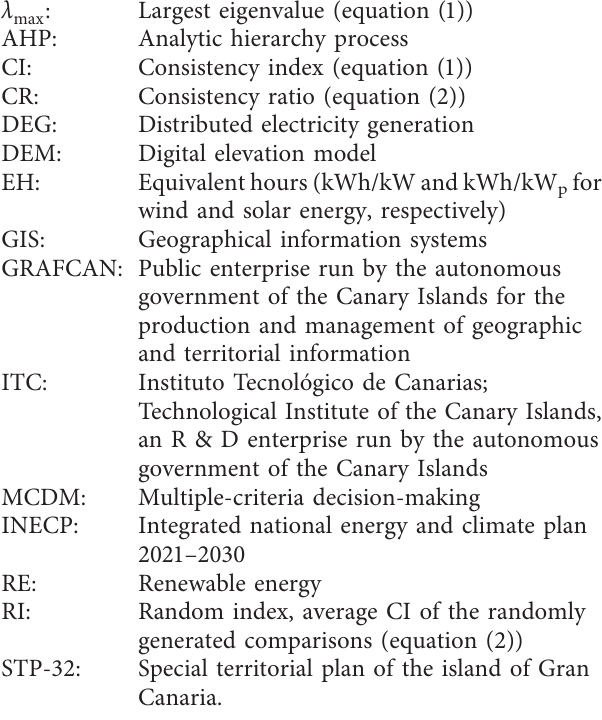
Table 8: Sensitivity analysis results of minimum score for priority site. Assigned value for minimum score